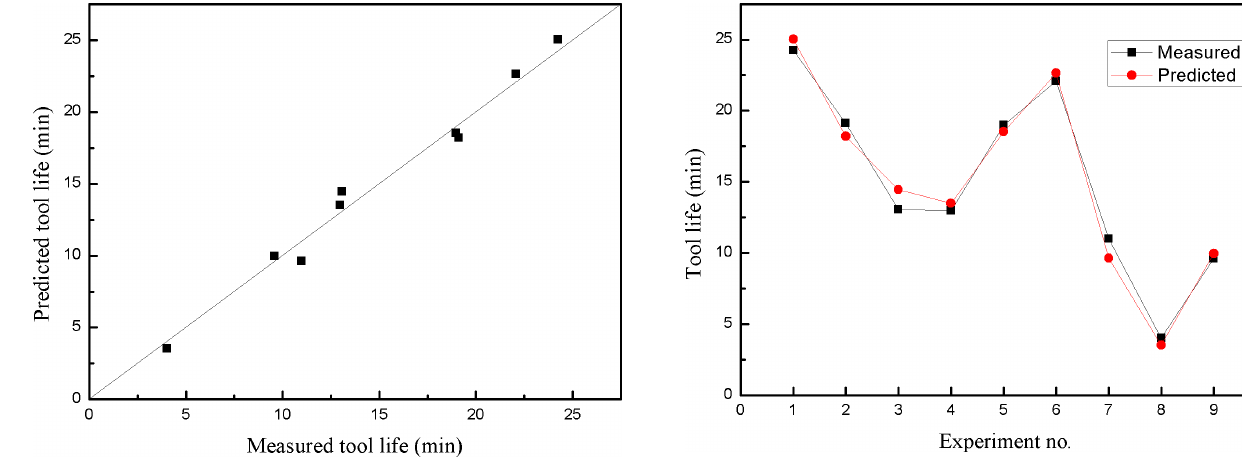
Figure 14. The diagram of measured tool life and predicted tool life for the testing data set.